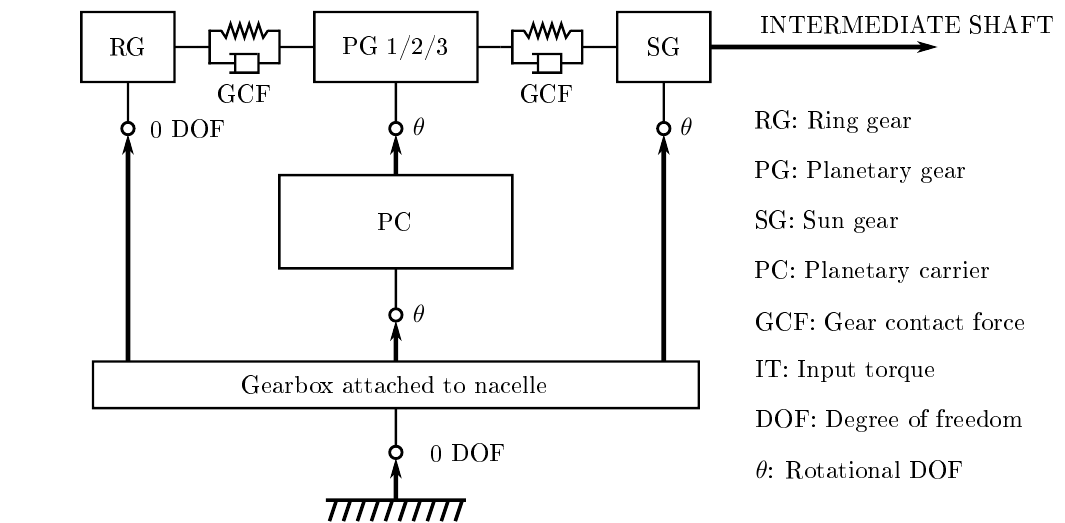
Figure 2: Topology diagram of the Matlab multibody gearbox model (as illustrated in Dong et al. (2012)). Wind speed [m/s]